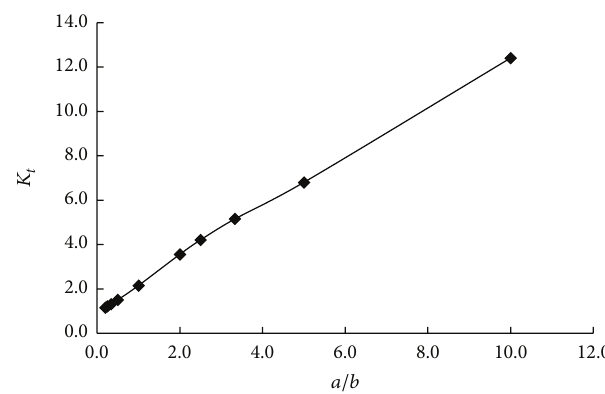
Figure 6: Variations of SCF with 𝑎/𝑏 for 𝑎 = 2 mm.